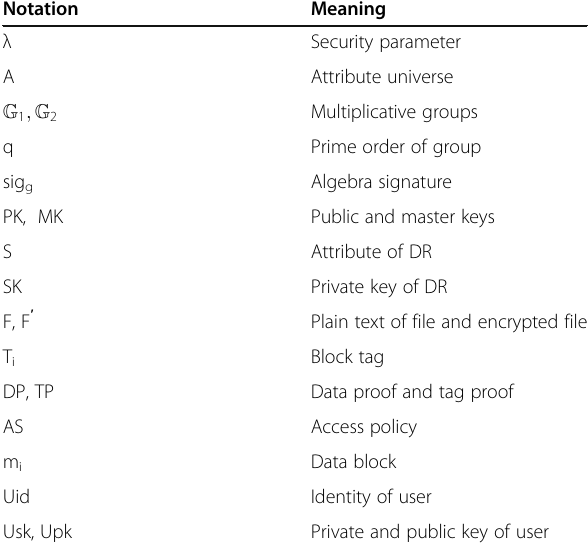
Table 1 Important